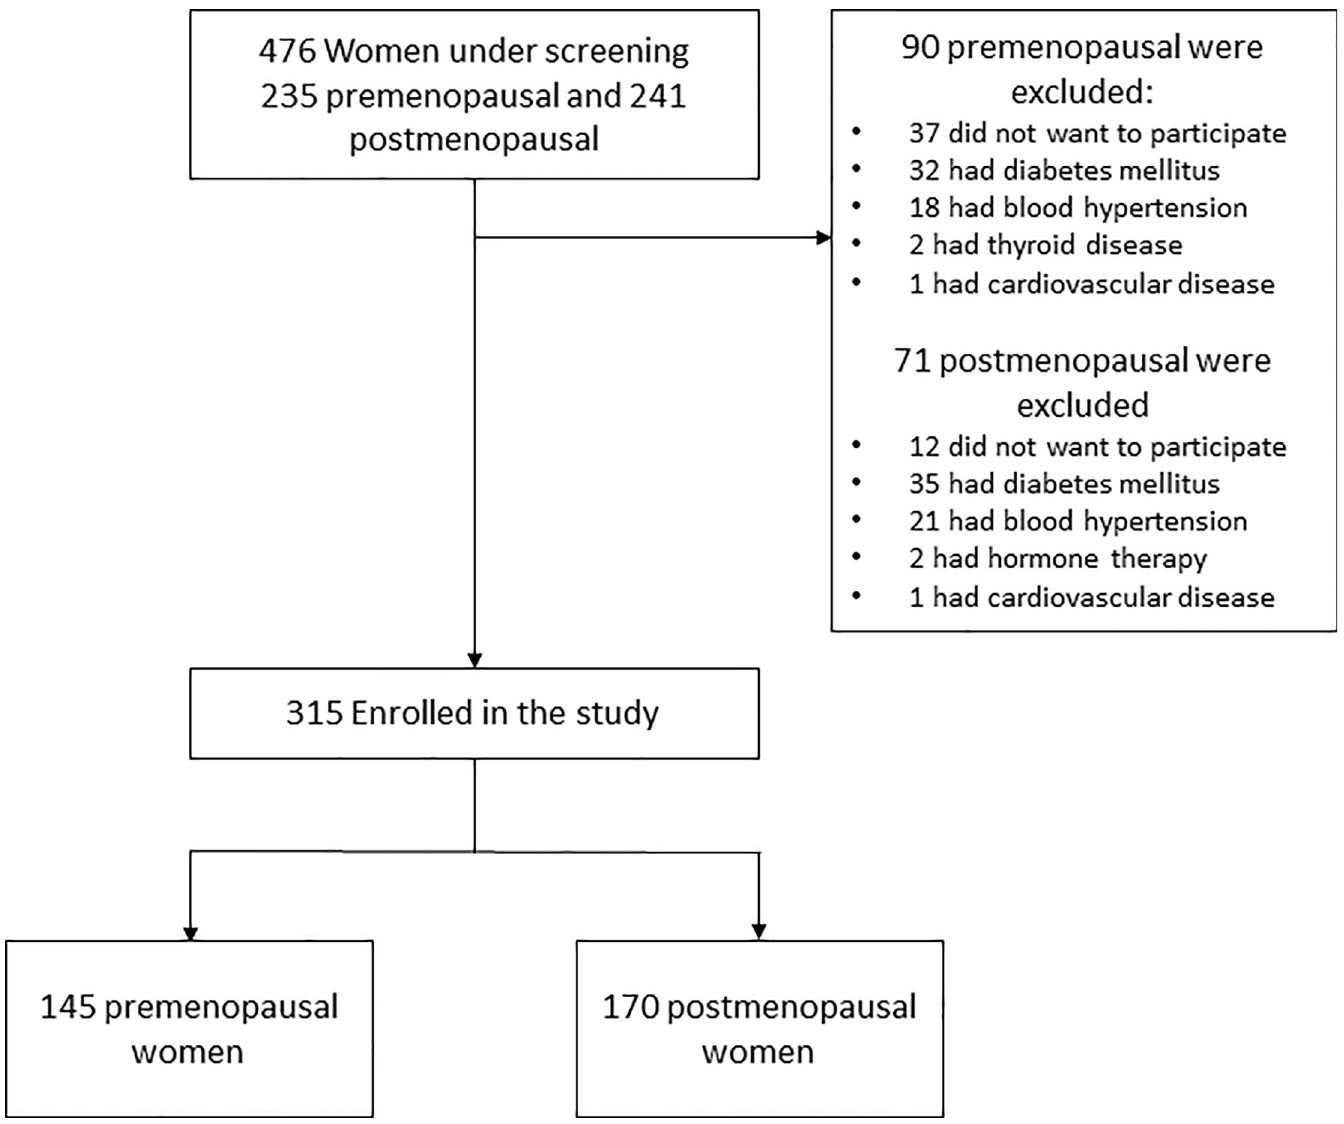
Fig 1. Diagram of the inclusion of study